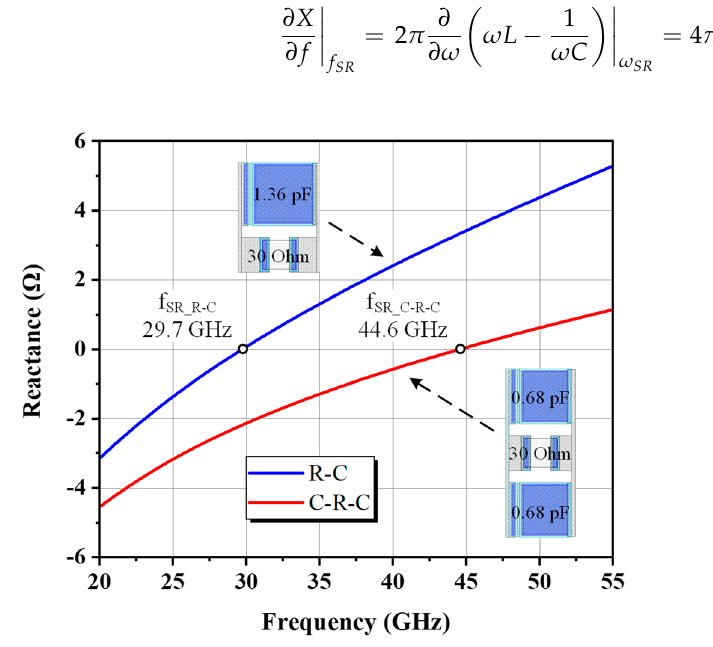
Figure 3. The reactance of a parallel RC stabilization network.